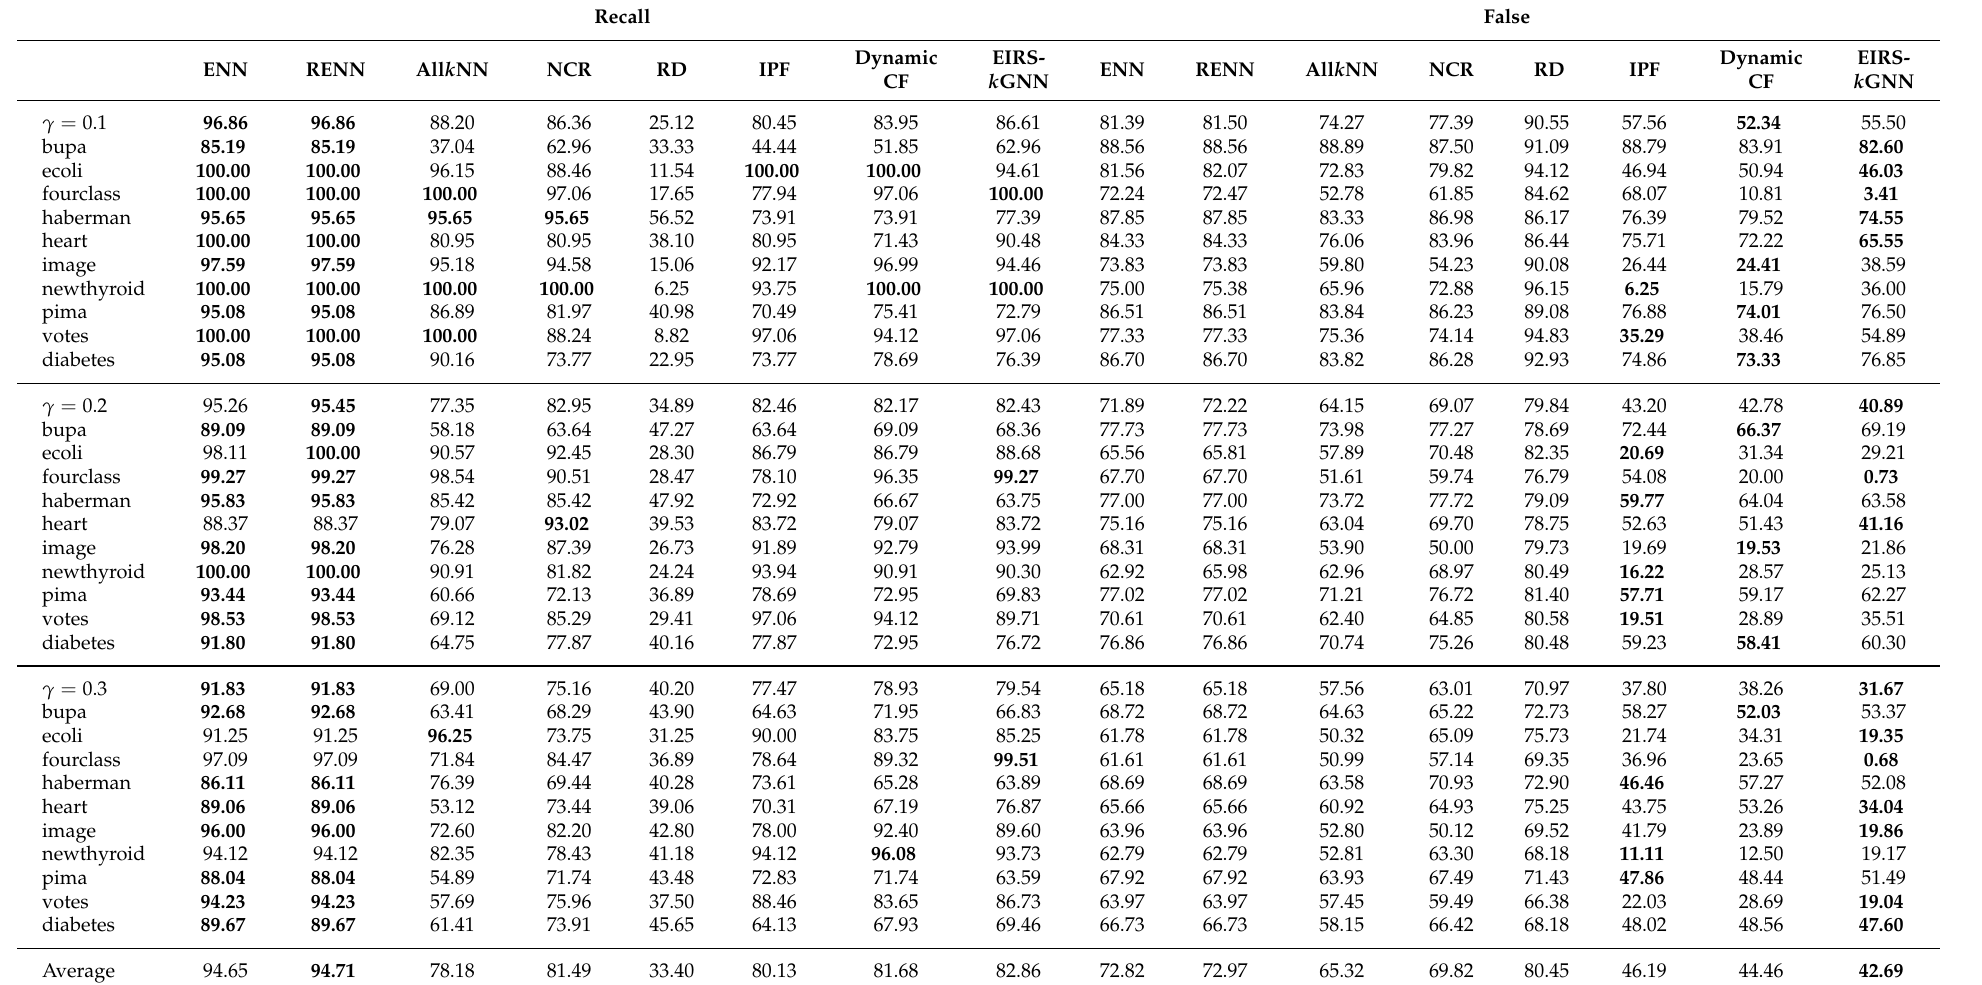
Table 2. Average results (%) comparison of label-noise detection performances at varying γ